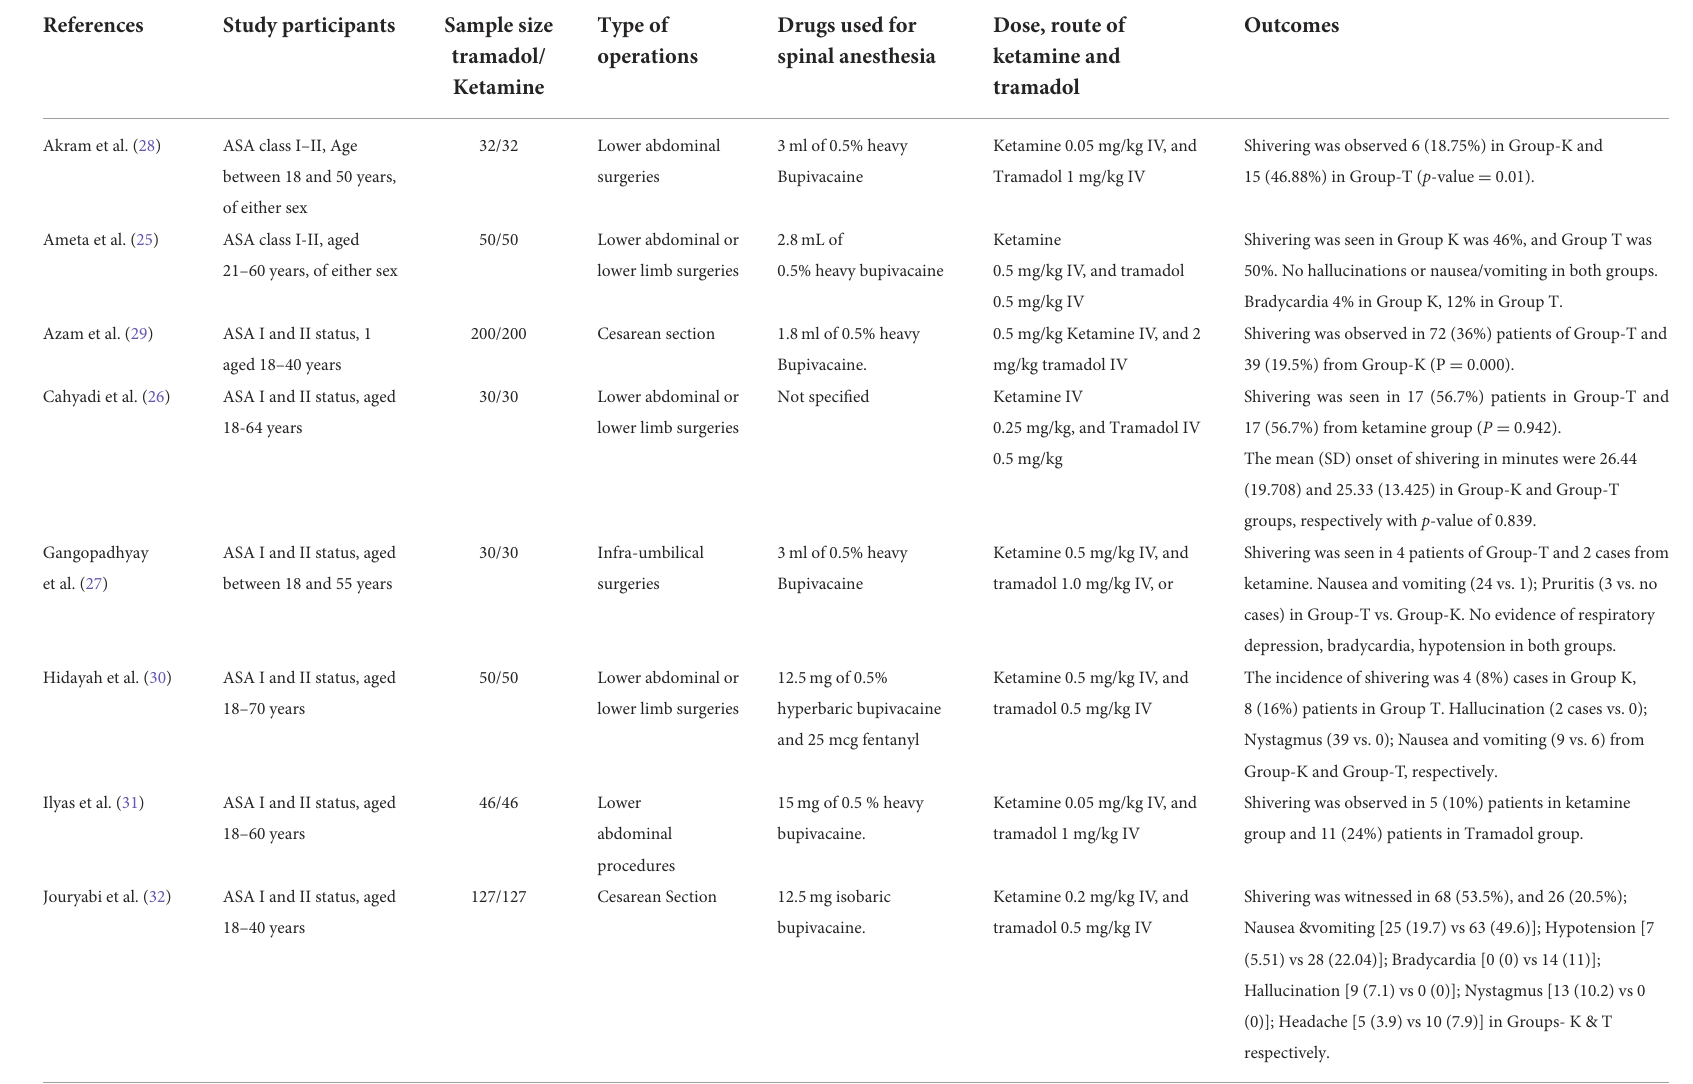
TABLE 1 Characteristics of included